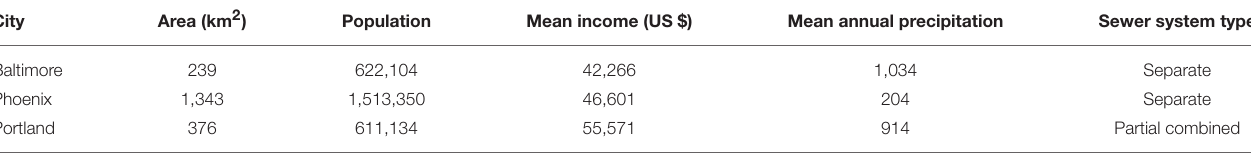
TABLE 1 | Relevant city characteristics (as of